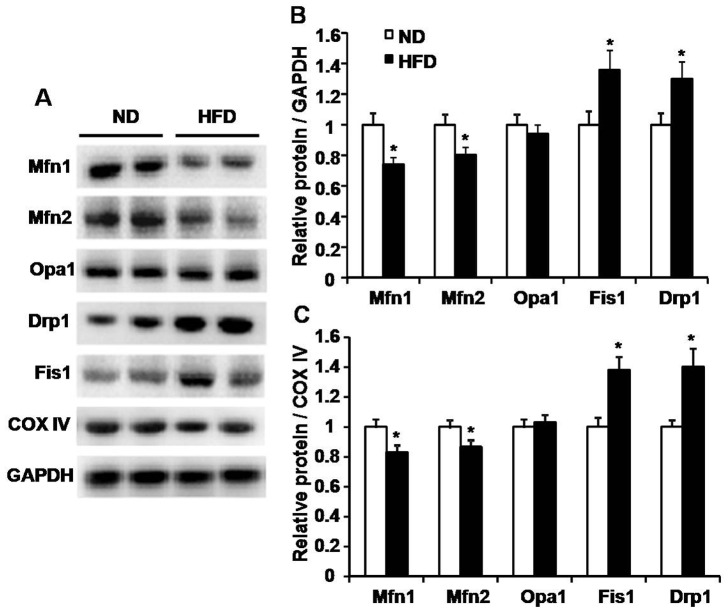
Expression of proteins regulating mitochondrial fusion and fission.A, Representative images of protein expression in skeletal muscle detected by western blot. B and C, The statistical results of normalized relative protein regulating mitochondrial fusion and fission/GADPH (B) or cytochrome c oxidase IV (COX IV) (C) ratio in skeletal muscle of HFD-induced mice when compared to control mice. n = 6 mice for each group. *, P<0.05 compared to ND.